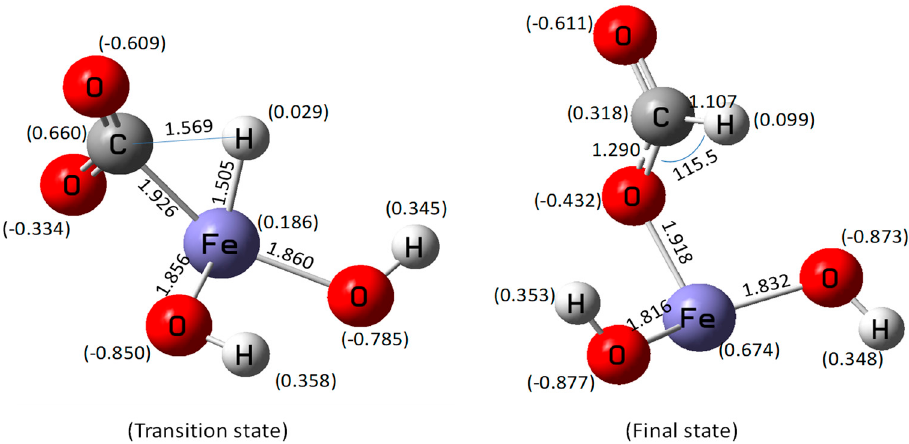
Figure 2. Optimized geometric parameters of the transition state and the final state.